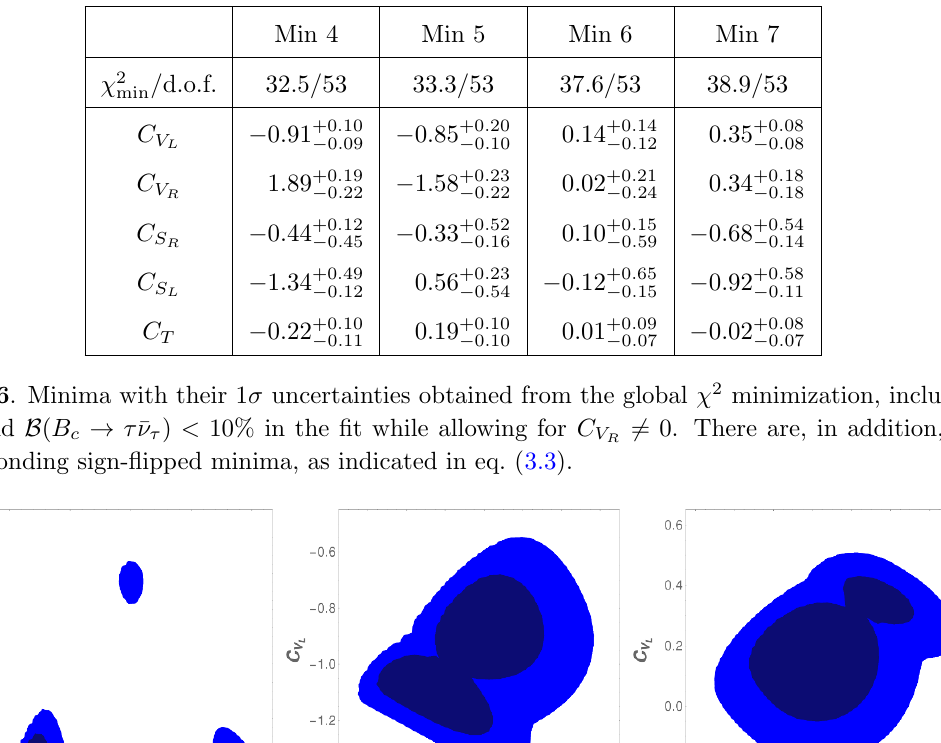
Figure 8 . Allowed regions in the C V R (cid:0) C V L plane, for the global (cid:12)t including F ( B c (cid:28)(cid:23) ) 10%. Lighter and darker blue areas show regions with 95% and 68% CL, respectively. B ! (cid:20) Left: all four minima shown in the chosen parameter convention with C V global minimum. Center: the two minima with C V 1, without restricting C V L (cid:24) (cid:0) Right: the two minima with C V < 1, relative to Min R;L j j